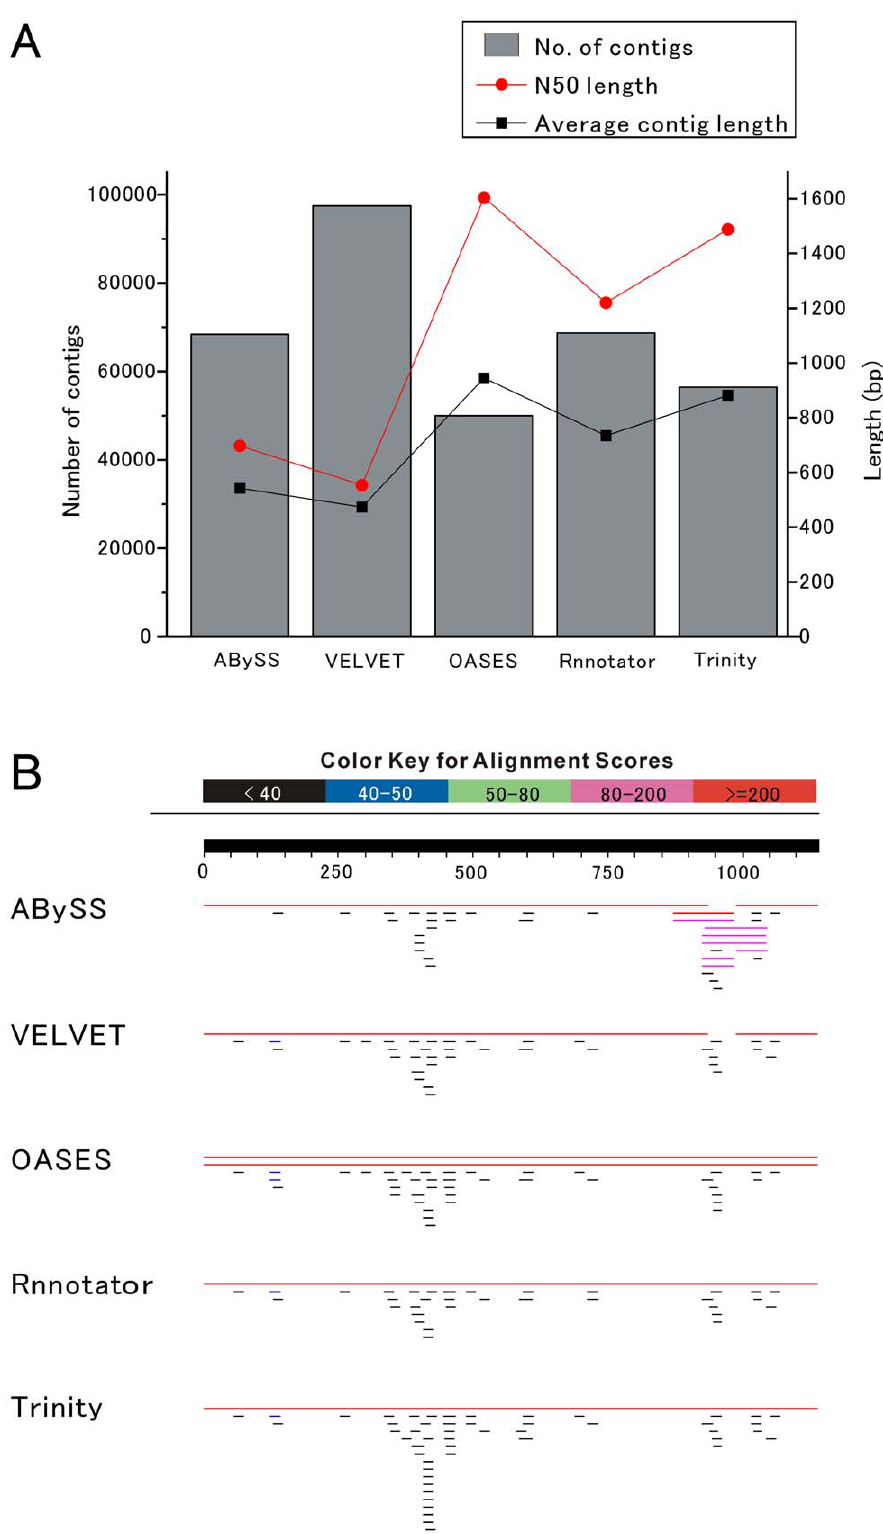
Figure 2. Comparison of denovo assembly quality among the different programs. (A) Overall comparison of the results from five assembly programs. The bars indicate the number of contigs longer than 200 bp (left axis). The red lines indicate the N50 length and the black lines indicate average contig length in bp (right axis). (B) Blast requests of LymCREB2 CDS (1,140 bp) for differently assembled contigs. The black line above represents the query sequence and the colored lines below represent the results of the similarity of hit contigs in the databases. The alignment scores are indicated by five colors in the label at the top.